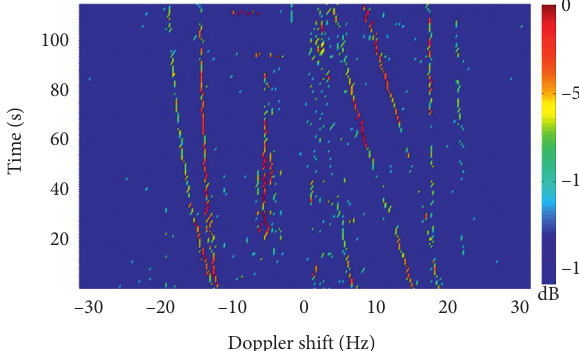
Figure 4: Time-doppler map.